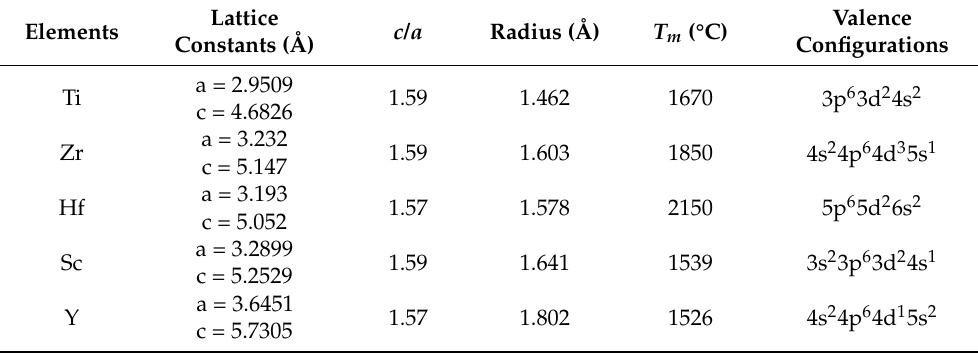
Table 2. Lattice parameters and physical properties [41,42] of HCP constituent alloy elements of CSAs studied in this work.